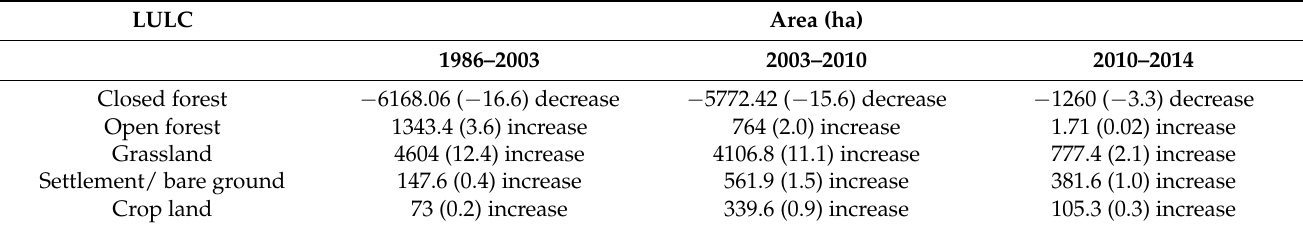
Table 7. Land use and land cover (LULC) change in the Bobiri forest reserve from 1986 to 2014. LULC